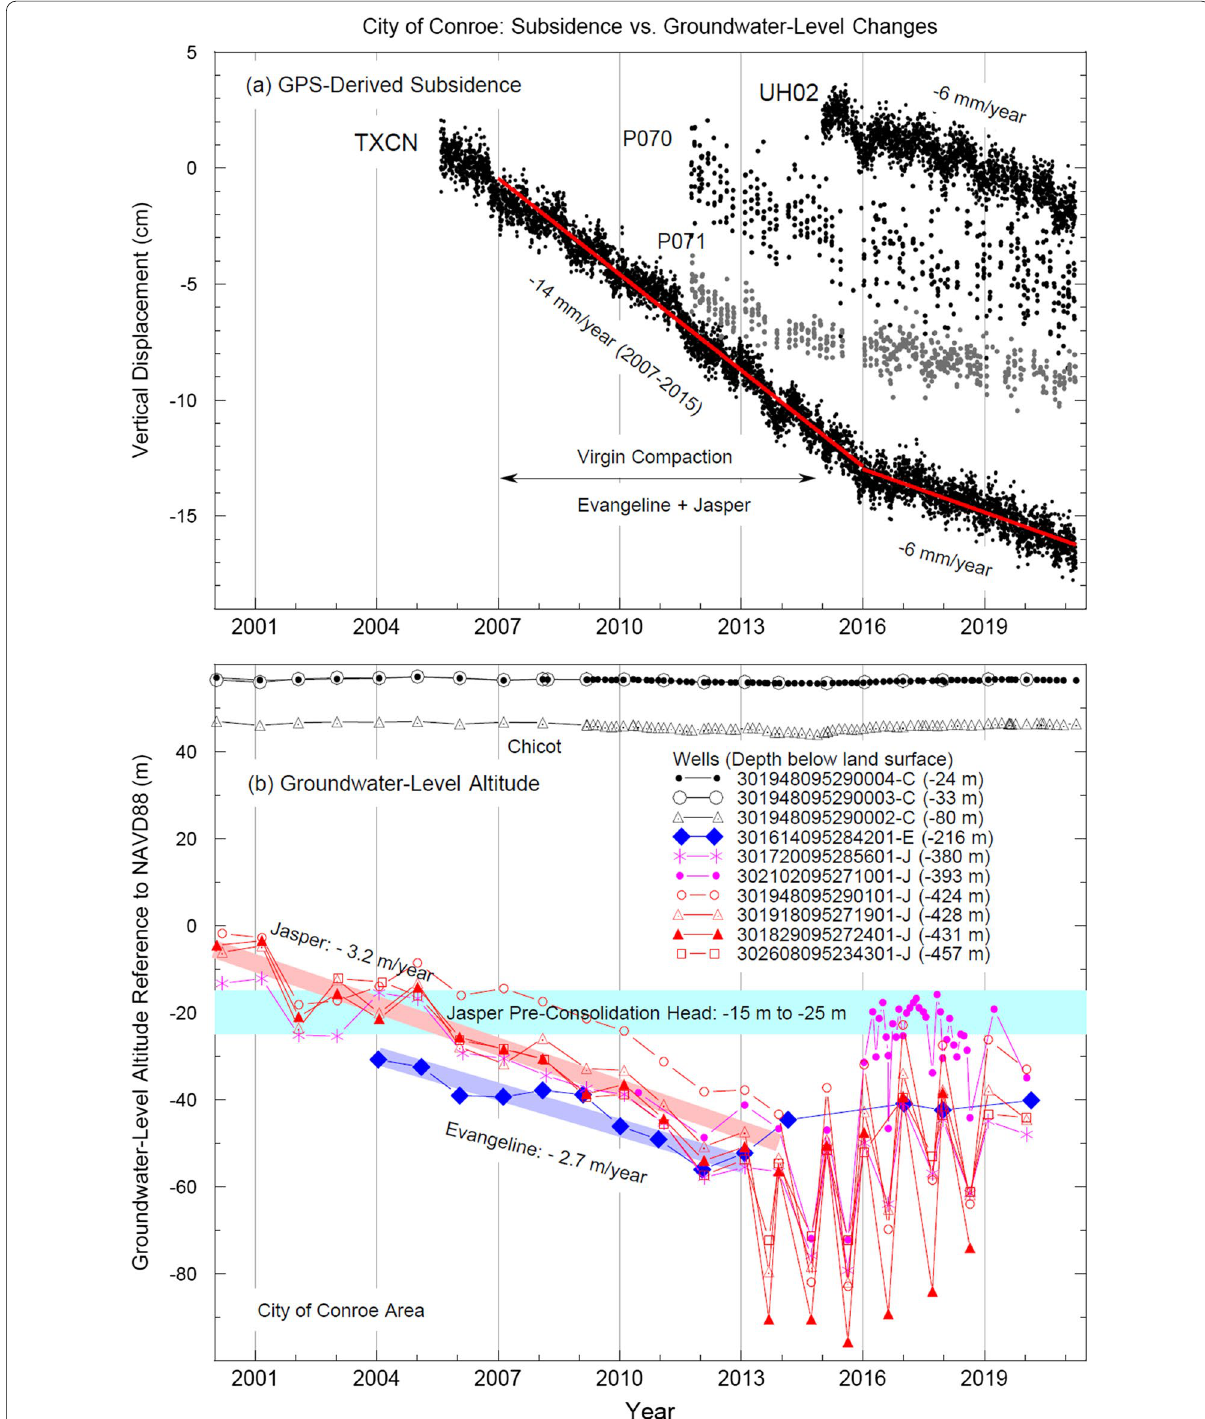
Fig. 15 GPS-derived land subsidence and groundwater-level changes in Conroe area. The locations of these wells and GPS are marked in Fig.